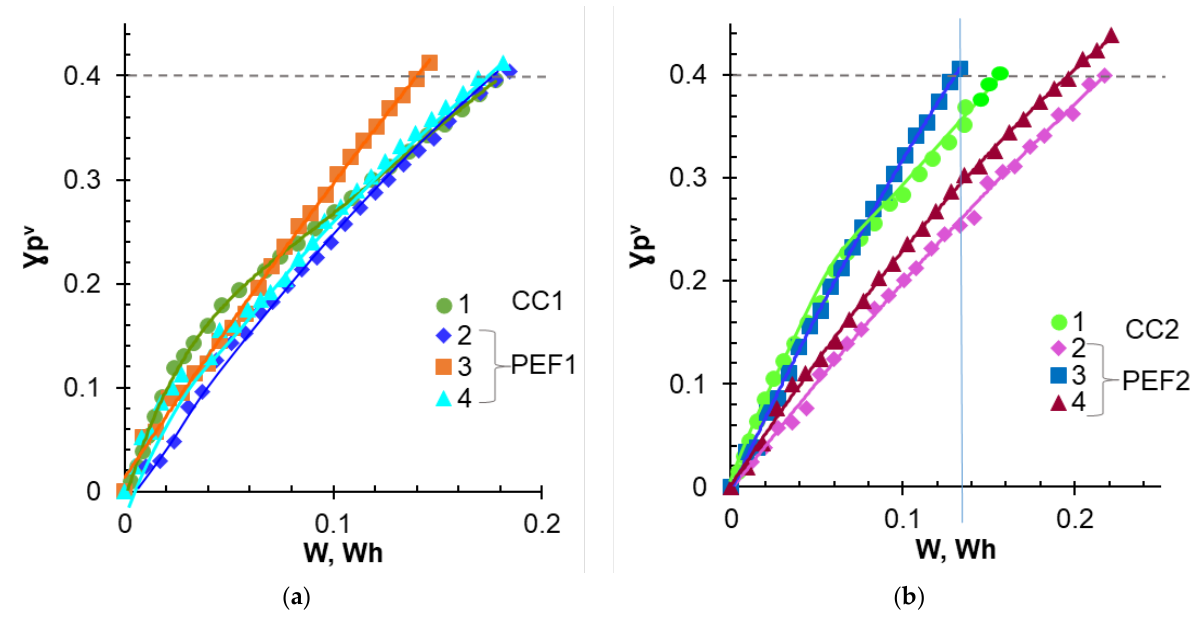
Figure 3. Changes in the NaH 2 PO 4 concentration in the diluate loop ( a ) and the potential drop be- tween Luggin capillaries ( b ) vs. the duration of 0.03 M NaH 2 PO 4 solution desalination at i av = i CC1 = 3 mA cm − 2 . Other parameters of the current modes are given in Table 3.